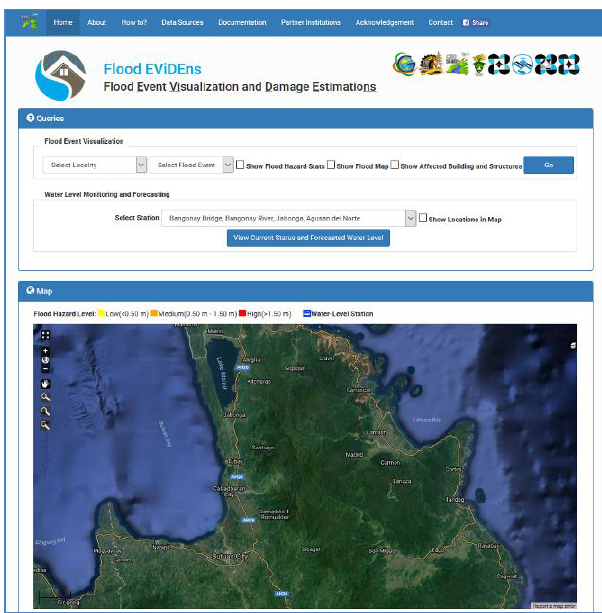
Figure 3. The Flood EViDENs graphical user interface.